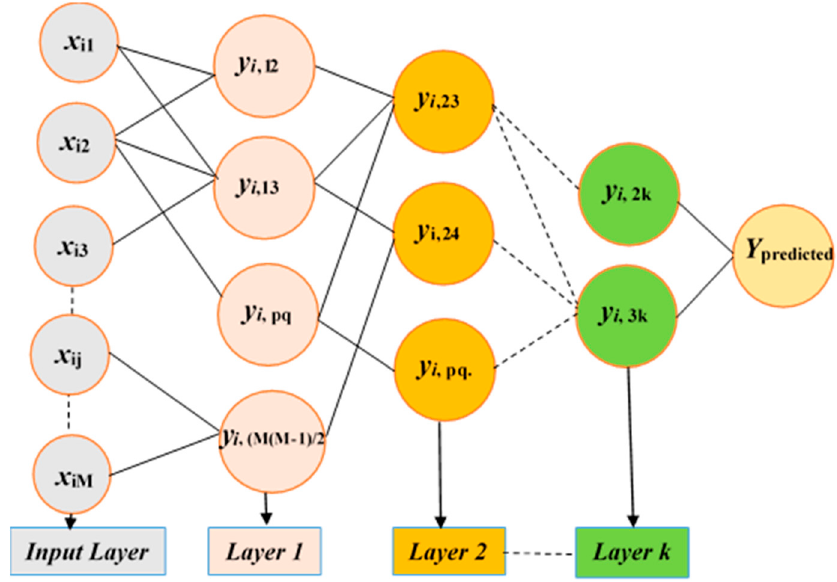
Figure 4. Network of self-organizing group method of data handling (GMDH) algorithm with M inputs and k layers.